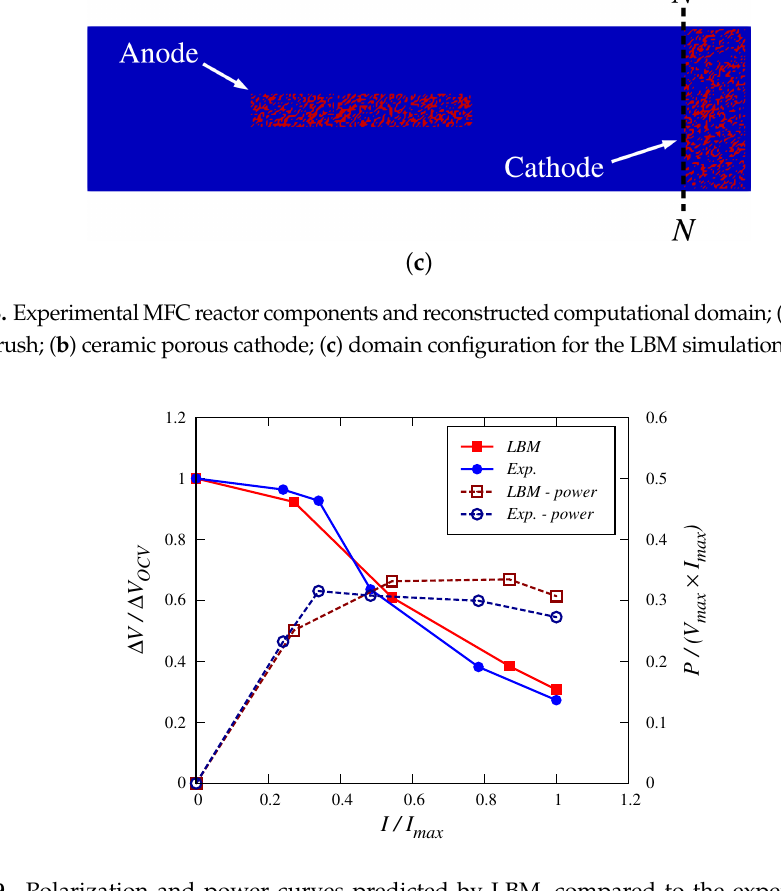
Figure 9. Polarization and power curves predicted by LBM, compared to the experimental data presented in